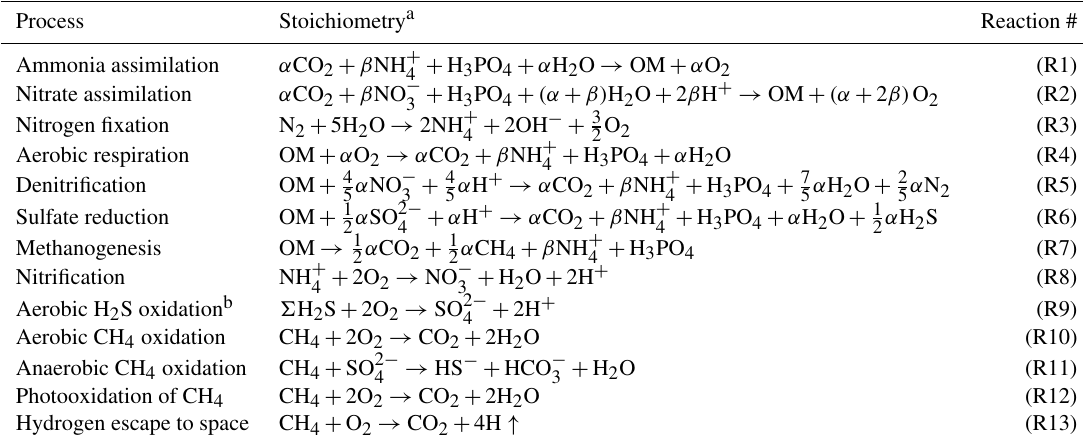
Table 1. Biogeochemical reactions considered in the CANOPS-GRB model. Process Stoichiometry a Reaction